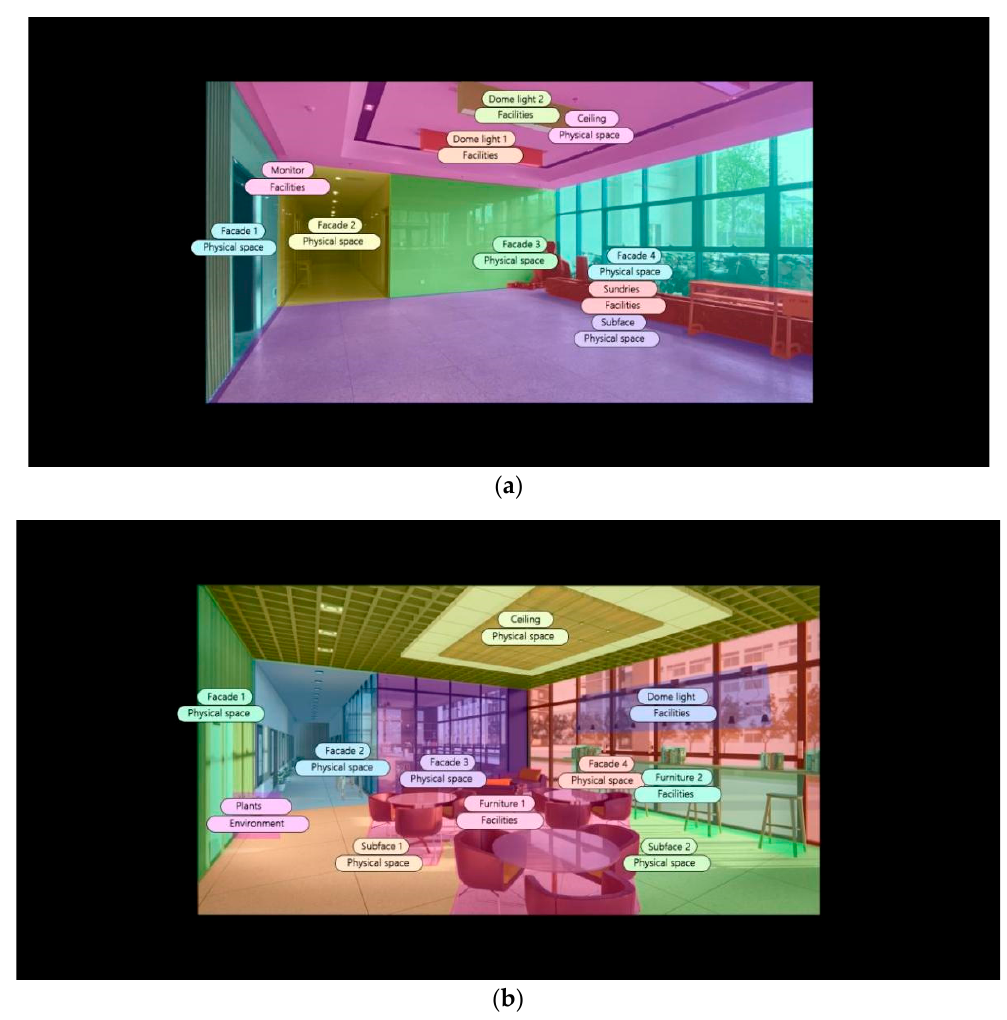
Figure 9. AOI division before and after optimization of the first-floor cafe. ( a ) Before optimization. ( b ) After optimization.